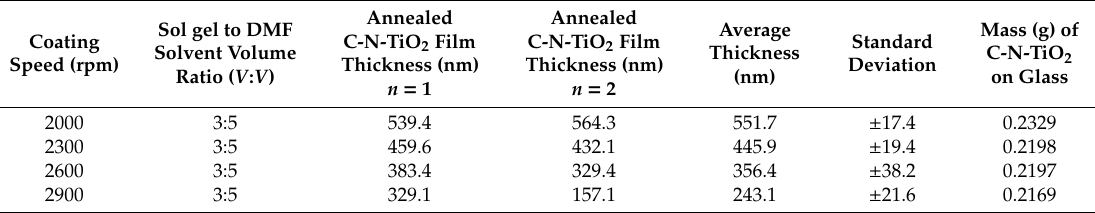
Table 1. E ff ect of spin coating speed on the thickness of the C-N-TiO 2 films: sol gel: solvent